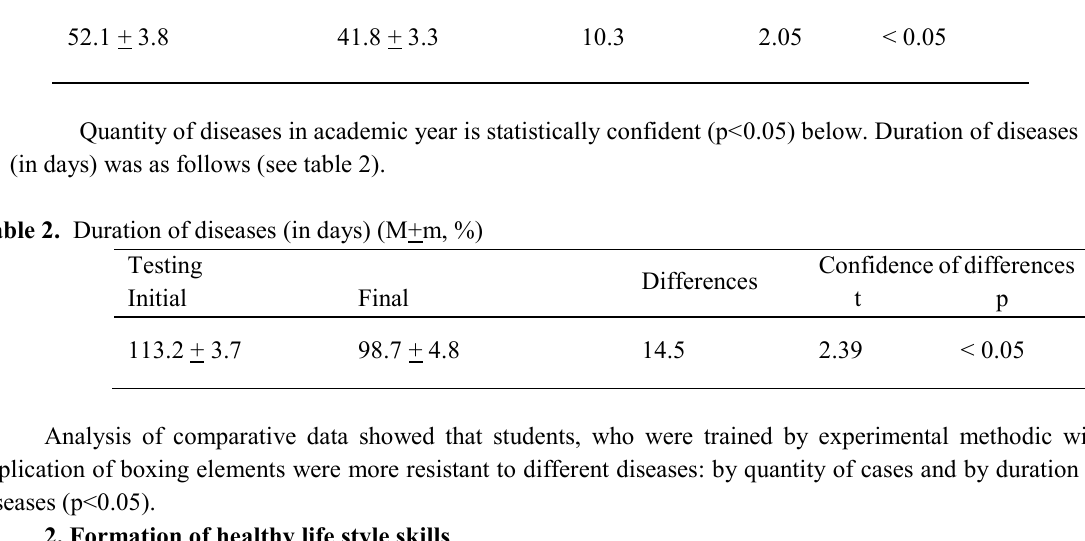
Confidence of differences Differences